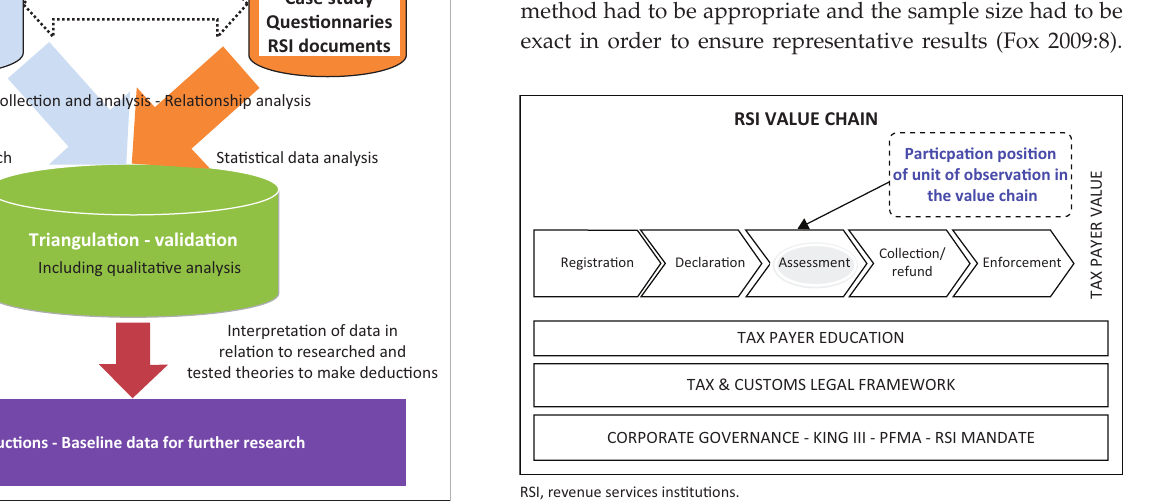
FIGURE 3: Revenue services institutions value